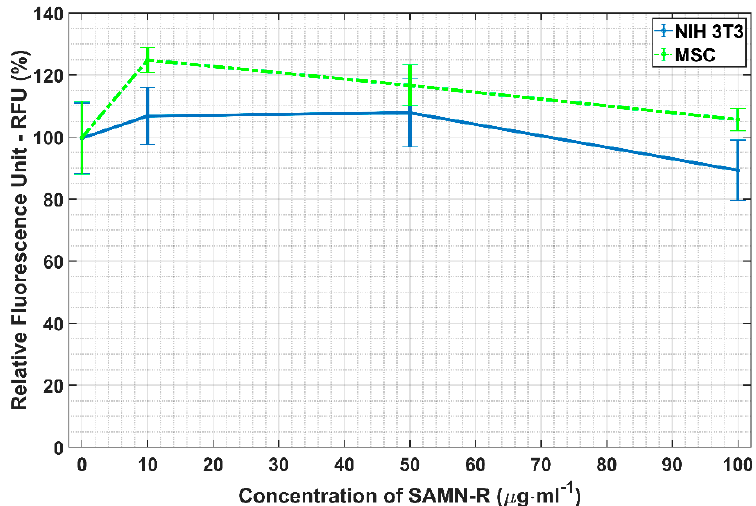
Figure 4. Measurement of reactive oxygen species (ROS) after cell labelling. The intensity of indicator CM-H2DCFDA was measured for four different labelling concentrations. The horizontal segment (whiskers) marks the standard deviation of fluorescence intensity.